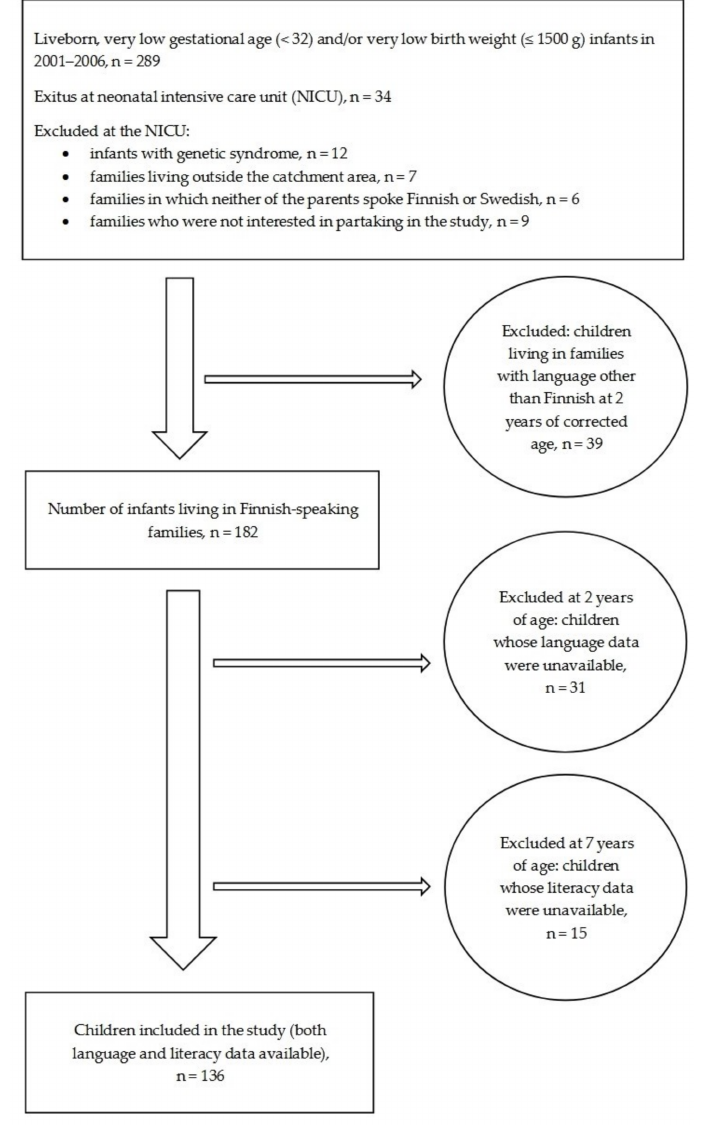
Figure 1. Flow chart of the prematurely born children born at very early gestational age (<32 weeks, very preterm, VP) and/or with very low birth weight ( ≤ 1500 g, VLBW) included in the